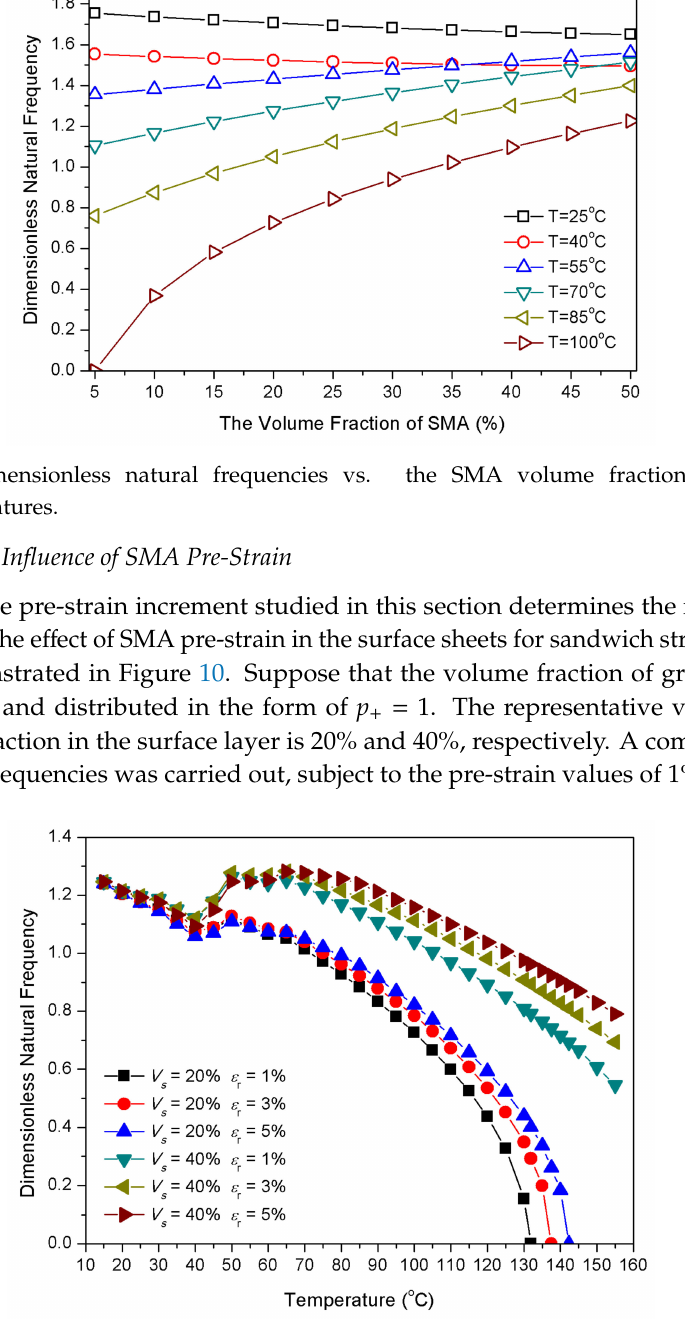
Figure 10. A comparison of dimensionless natural frequencies between the SMA volume fraction of 20% and 40% subjected to pre-strain 1%, 3% and